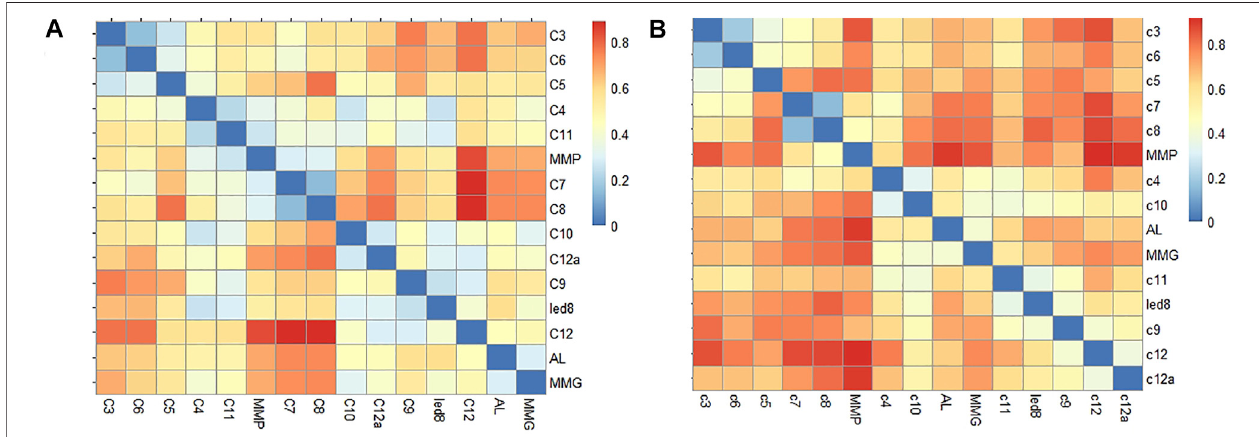
FIGURE10| Bray-Curtis dissimilarityheatmapforphyla (A) and classes (B) .ThesamplesAL, MMGand MMPcorrespond topreviouslystudied samplesoftheice complex of Mamontova Gora: an active layer (AL), an ice wedge of the upper (MMG) and lower horizons (MMP). For numerical values see Supplementary Tables S2,